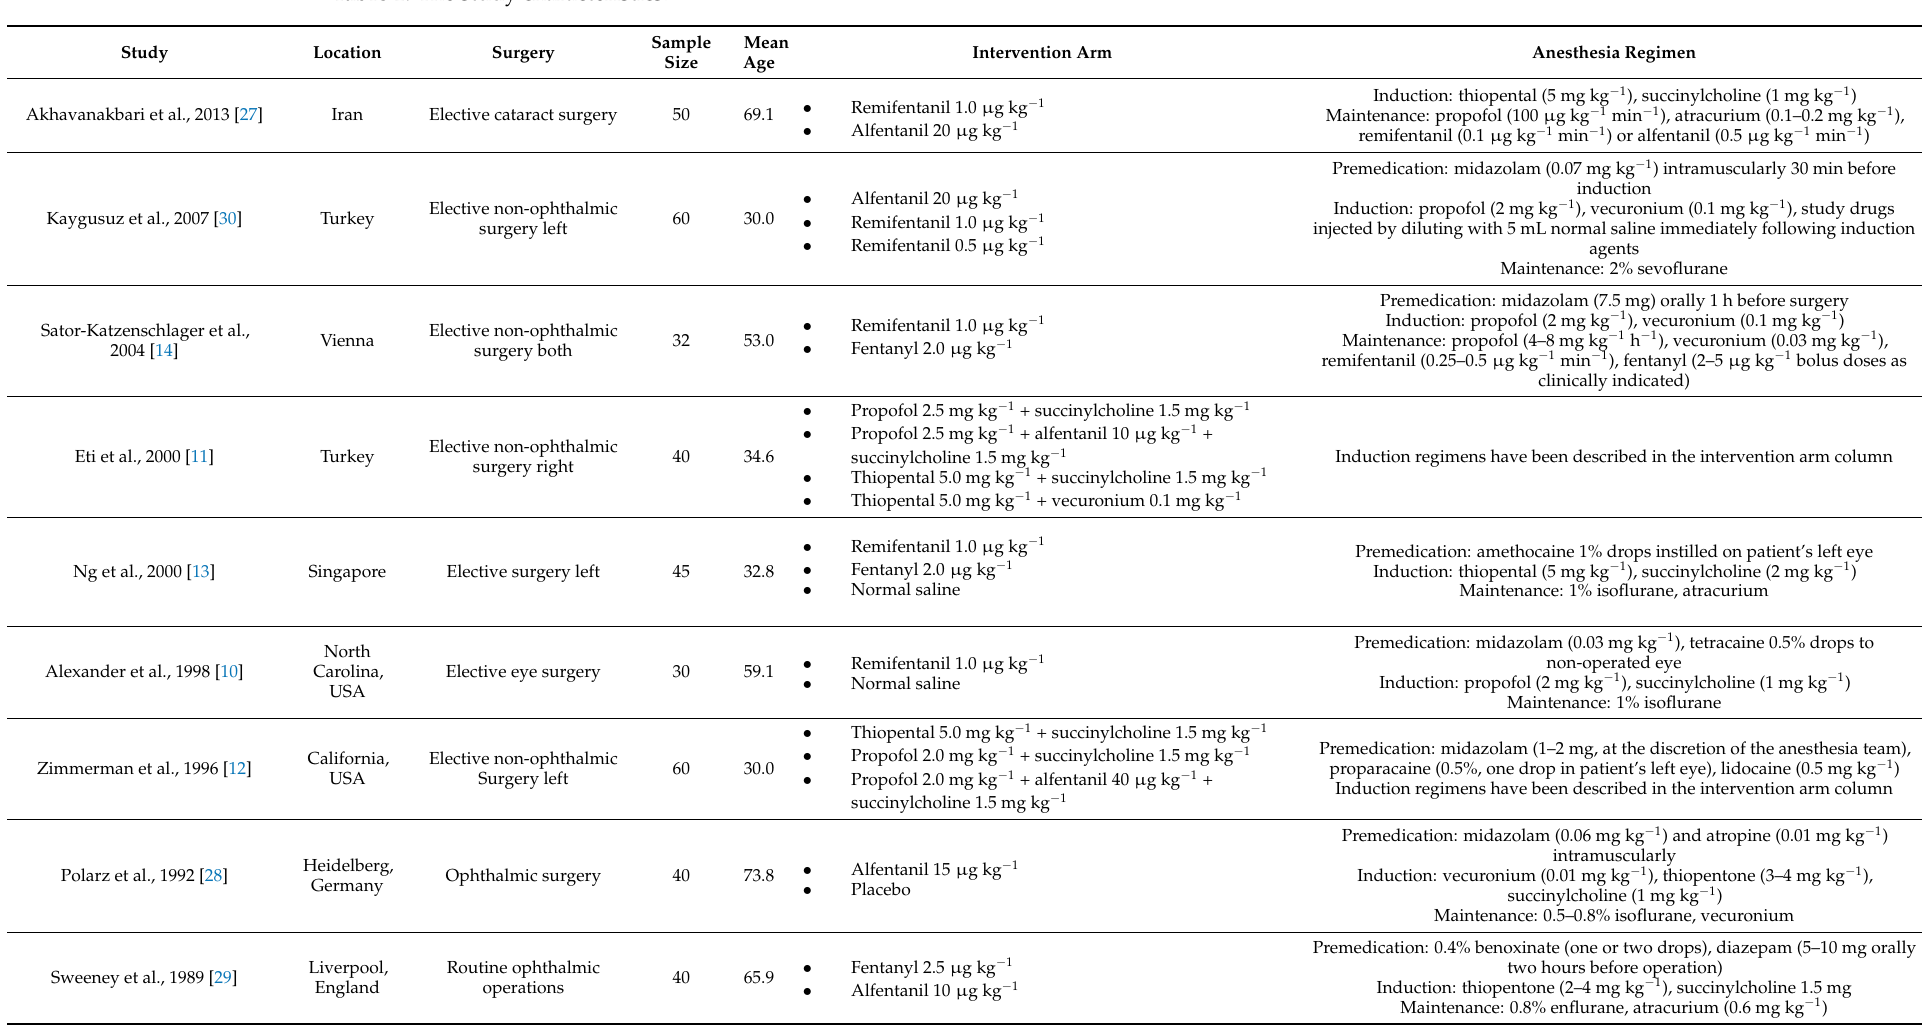
Table 1. The study